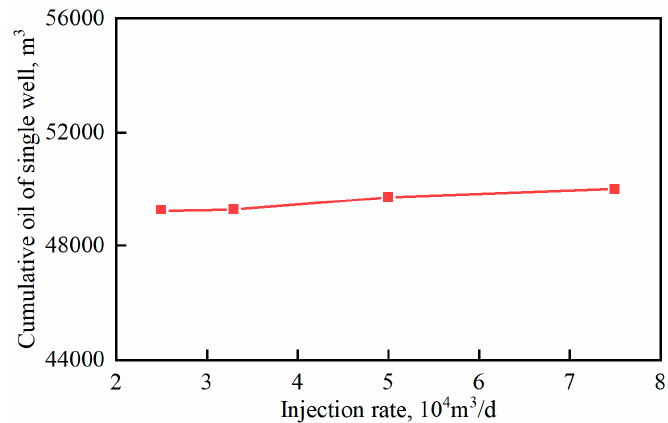
Figure 9. Comparison of cumulative oil production of the single well in each scheme under different CO 2 injection rates.